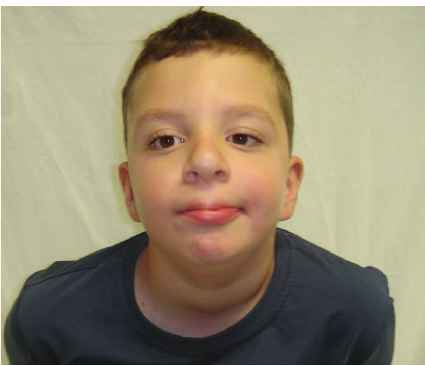
Figure 1: The patient at 10 years of